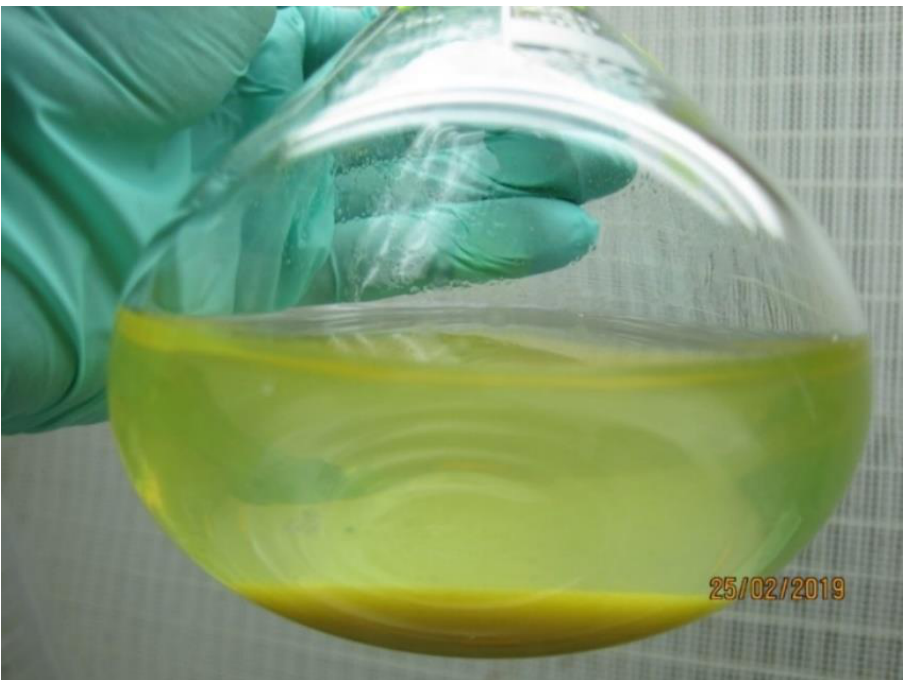
Figure 1. Conical flask with 3 years old cell suspension culture of Cyathea delgadii with yellow coloration of tissue and liquid medium.